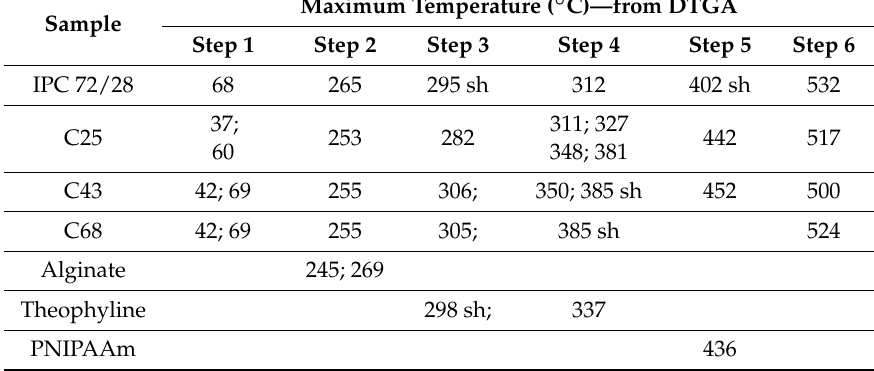
Table 3. Maximum temperature from DTGA for THP-loaded IPC, graft copolymers and their components and